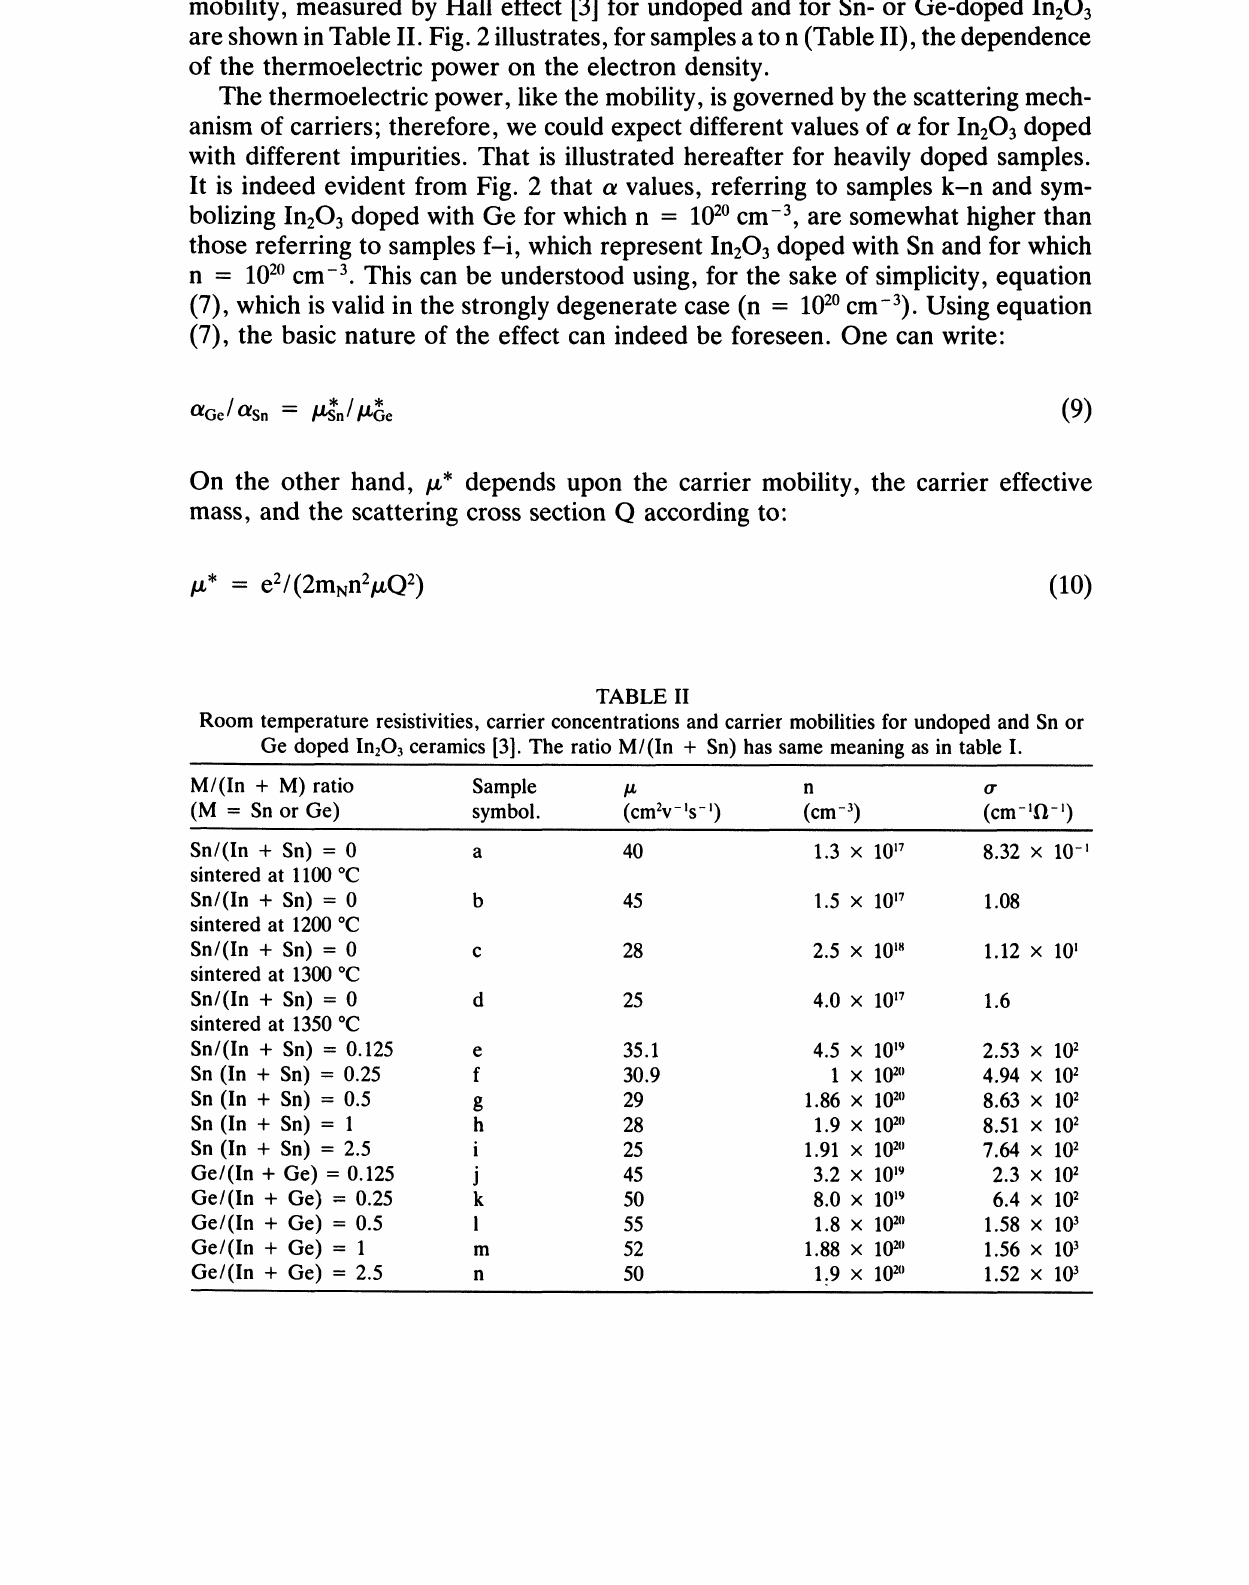
TABLE II Room temperature resistivities, carrier concentrations and carrier mobilities for undoped and Sn